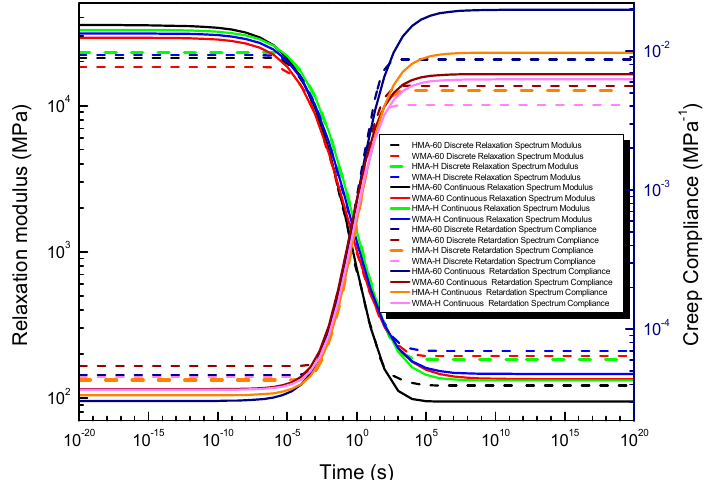
Figure 12. Compared the relaxation modulus and creep compliance obtained from the discrete and continuous spectrum.